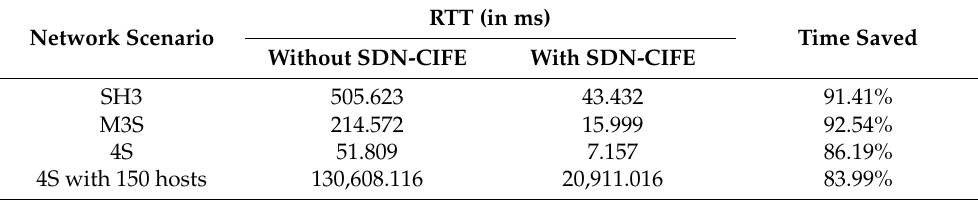
Table 5. First Packet Processing